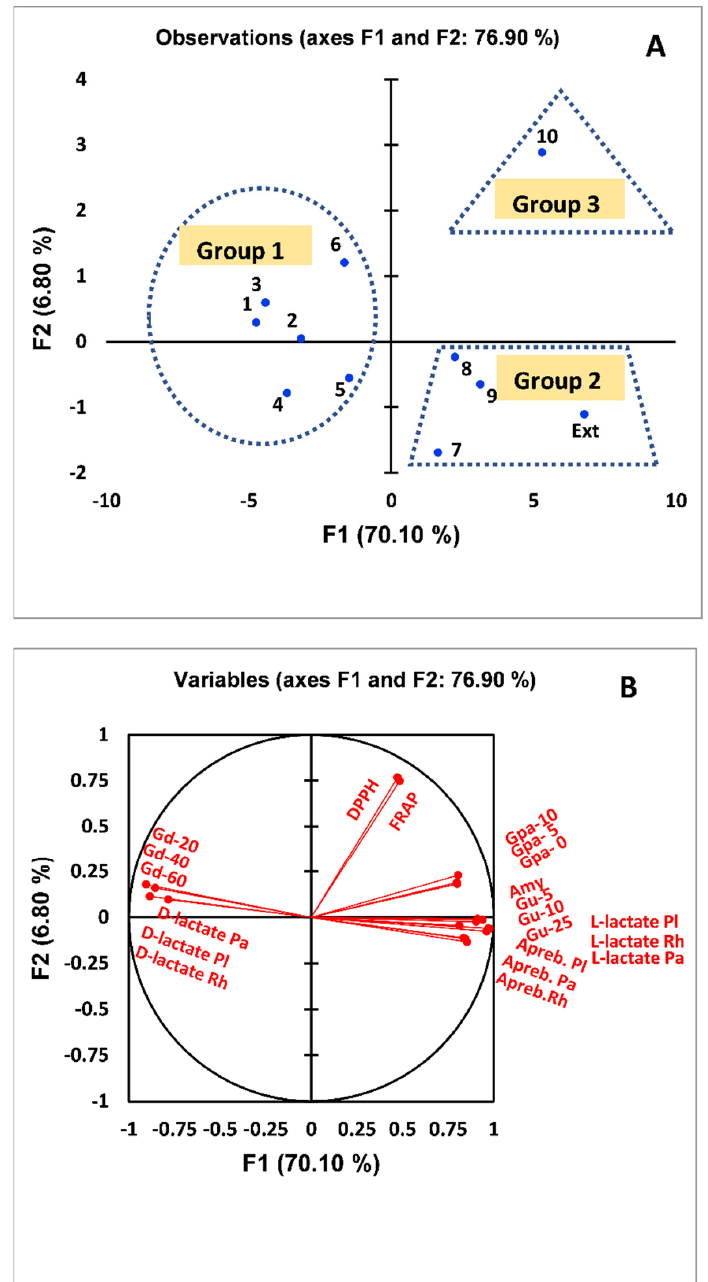
Figure 9. ( A ) Biplot of the principal component analysis (PCA) of the impact of the G. abyssinica extract and isolated bioactive compounds on the prebiotic activity score (A preb ), D-( − )-lactic acid and L-(+)-lactic acid levels, antioxidant activity (DPPH and FRAP assays), glucose uptake by yeast cells (Gu), inhibition of α -amylase (Amy) and glycogen phosphorylase (Gpa) activities, and glucose diffusion (Gd). ( B ) Analysis of the correlations among variables.